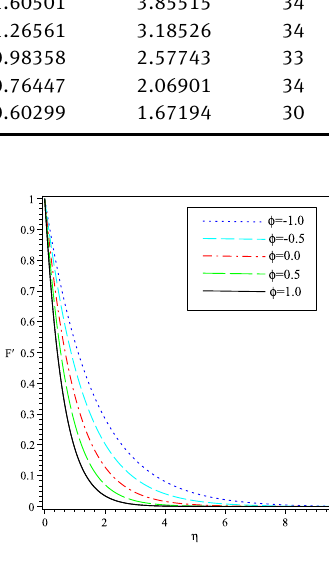
Fig. 8: The profile micro-rotation H ( η ) obtained by the indirect RBFs for different values of β at ϕ = 0 and ε = 0.1 .